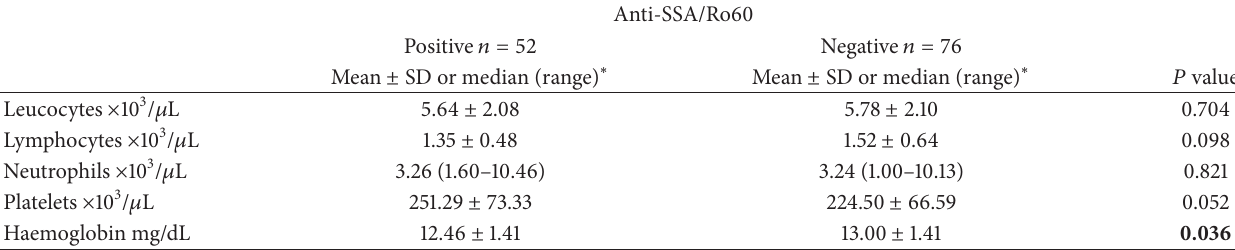
Table 5: Haematological parameters according to the anti-SSA/Ro60